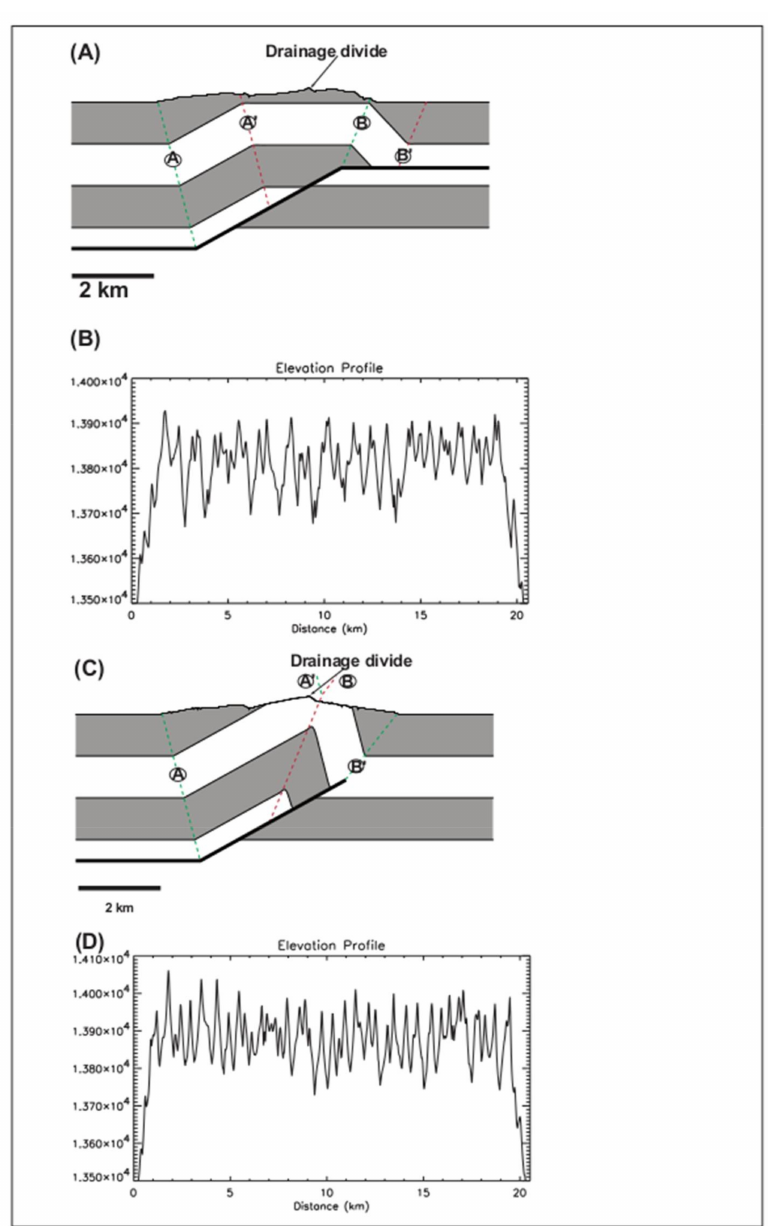
Figure 8. Cross sections ( A , B ) across final models of Figures 6 and 7 illustrating the relationship between structural position and drainage divides for instantaneous lateral propagation and constant slip distribution and ( C , D ) lateral elevation profiles. Location and orientation of the cross sections is indicated in Figures 6 and 7, elevation profiles have a vertical exaggeration of approx